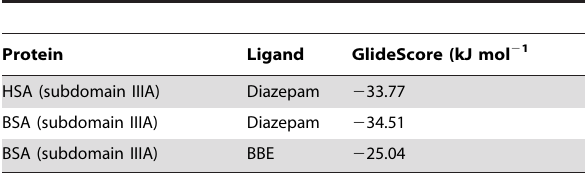
Table 4. Docking score (GlideScore XP) as calculated for the best poses for diazepam and